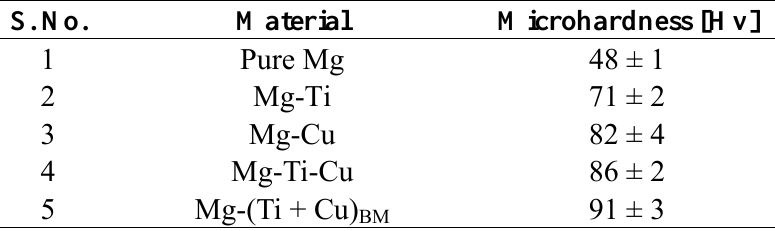
Table 3. Results of microhardness